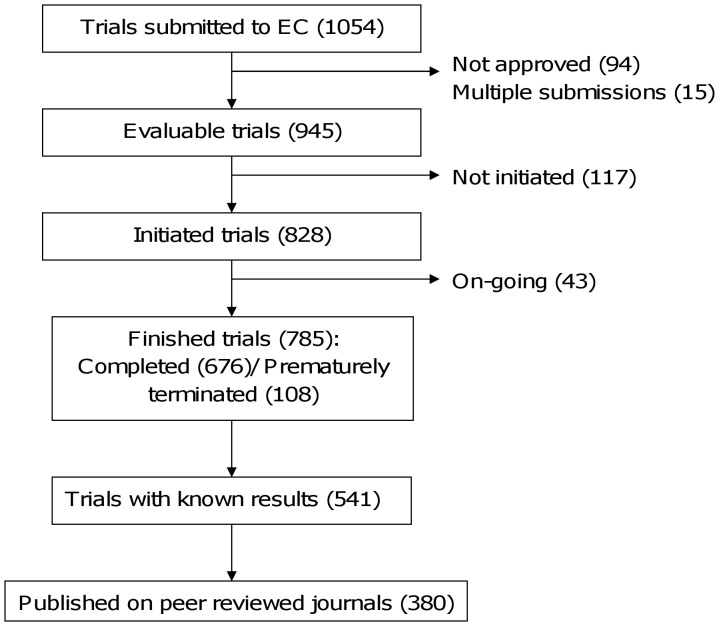
Flowchart of evaluated clinical trials.